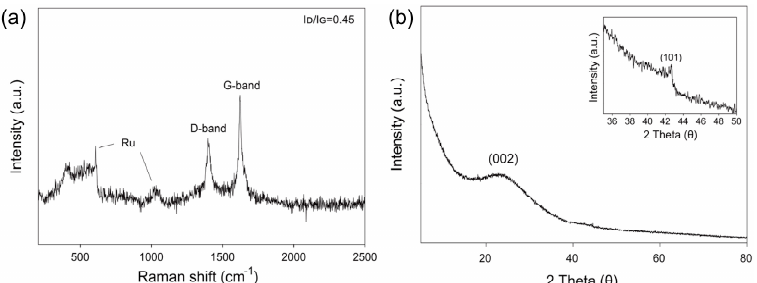
Figure 3. ( a ) Raman spectrum and ( b ) XRD pattern of RuO 2 /IL–graphene (Inset is high-resolution of the XRD pattern).